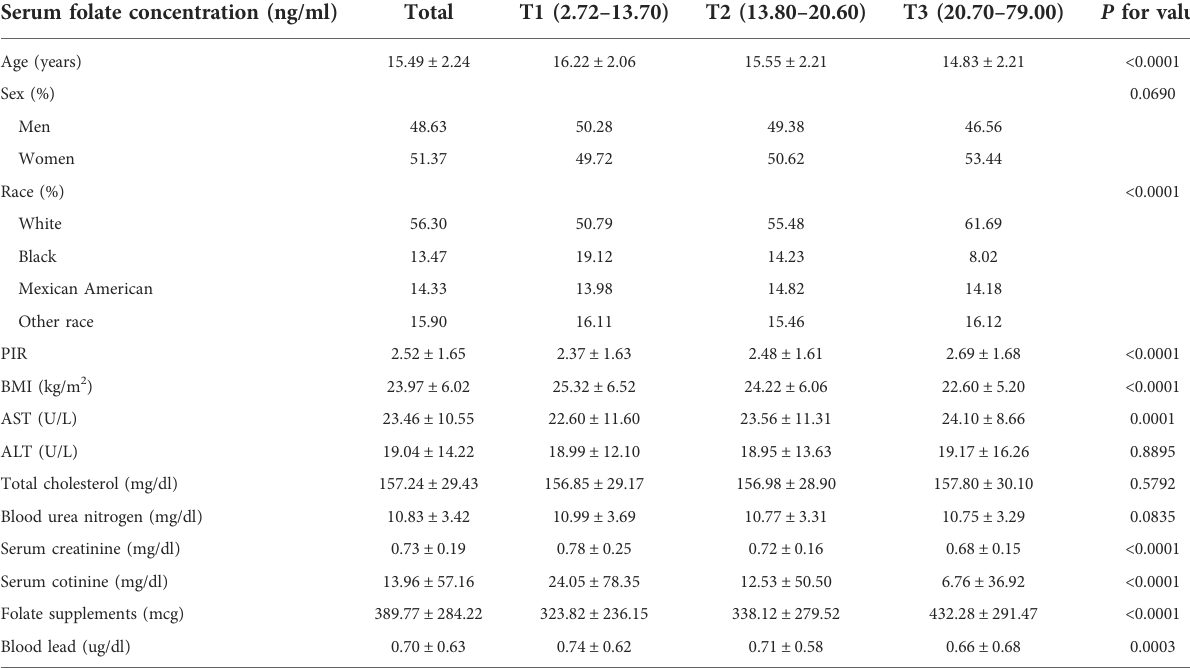
TABLE 1 Characteristics of the study population based on serum folate concentration tertiles. Serum folate concentration